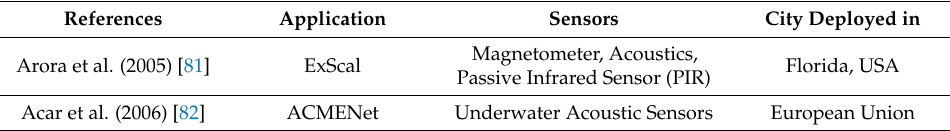
Table 12. Examples of prototyped applications for the military.